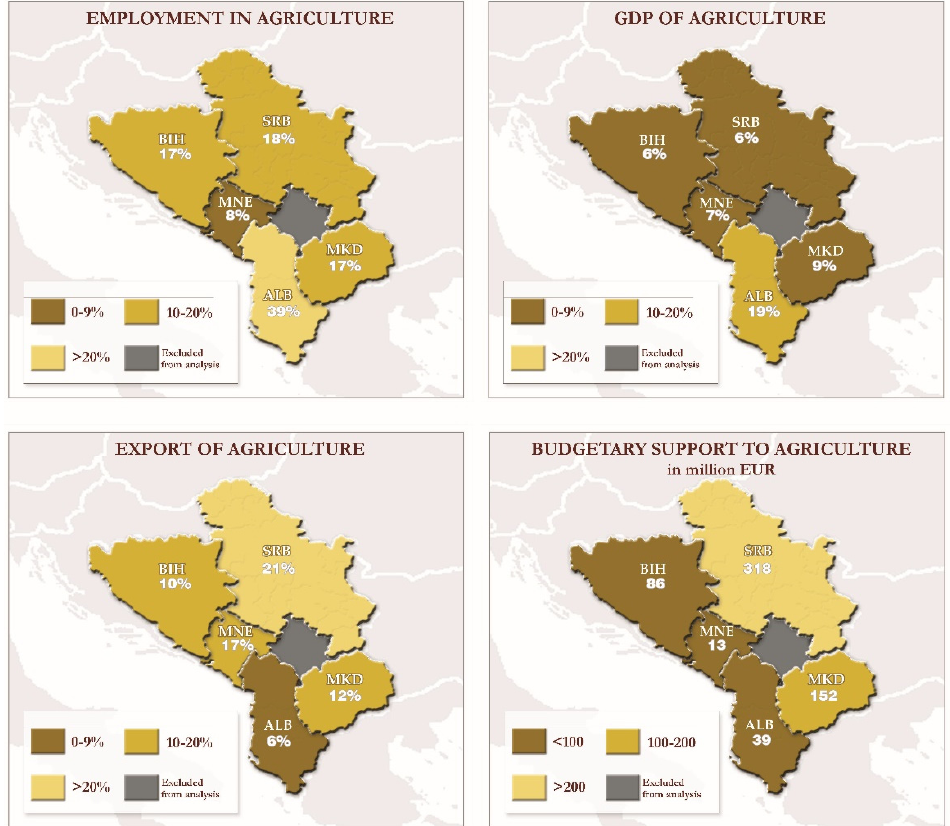
Figure 1. Economic relevance of agriculture in Western Balkans countries. Source: own research on the basis of FAOSTAT, World Bank, and APP